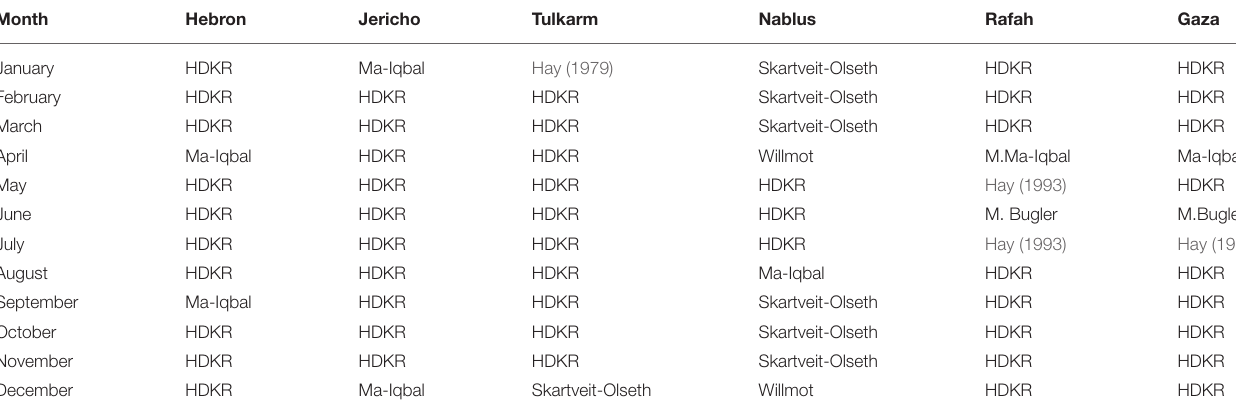
TABLE 4 | The monthly preferred model for each city from August 2017 until September 2018. Month